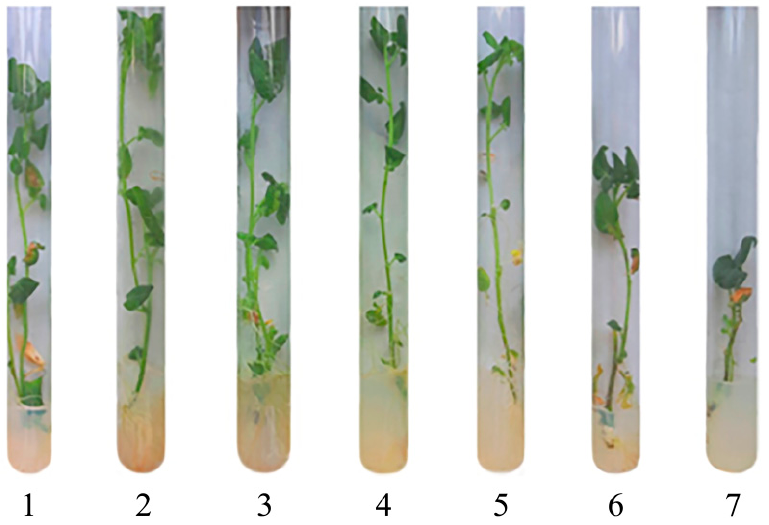
Figure 3. Photos of potatoes grown with different Mn sulfate content in the nutrient medium; (1)— 0 mol/L, (2)—0.1 mol/L (control), (3)—0.2 mol/L, (4)—0.5 mol/L, (5)—1, (6)—2 mol/L, (7)—10 mol/L.